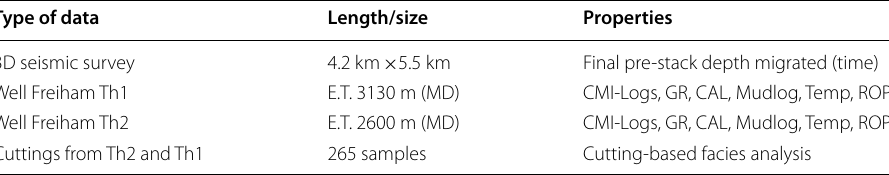
Table 2 Available database used in this